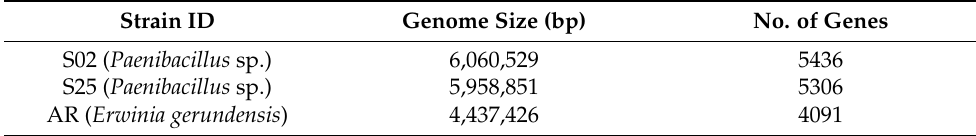
Table 2. General genomic characteristics of the three bacterial strains used in the assay. Strain ID Genome Size